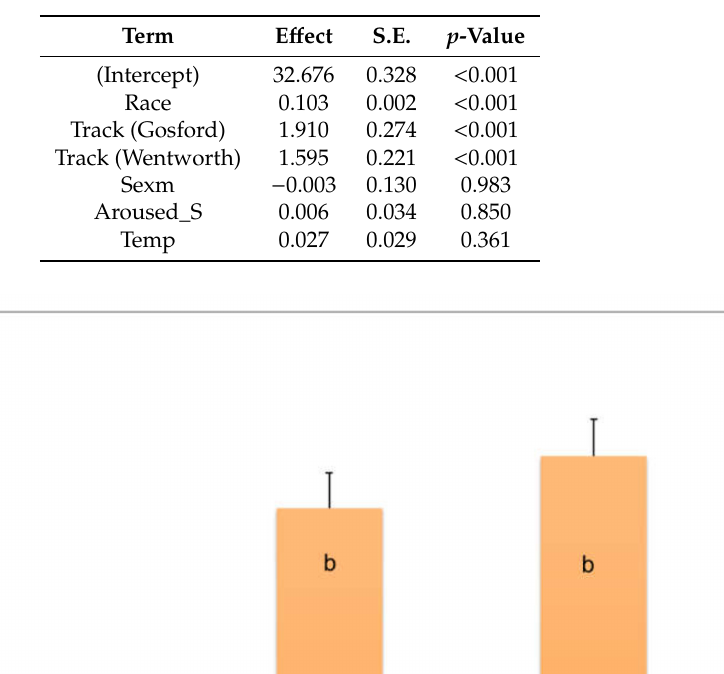
Table 6. Generalised linear model summary for Eye Temp Before races. Track and increasing race number both have significant, positive e ff ects on Eye Temp Before races.